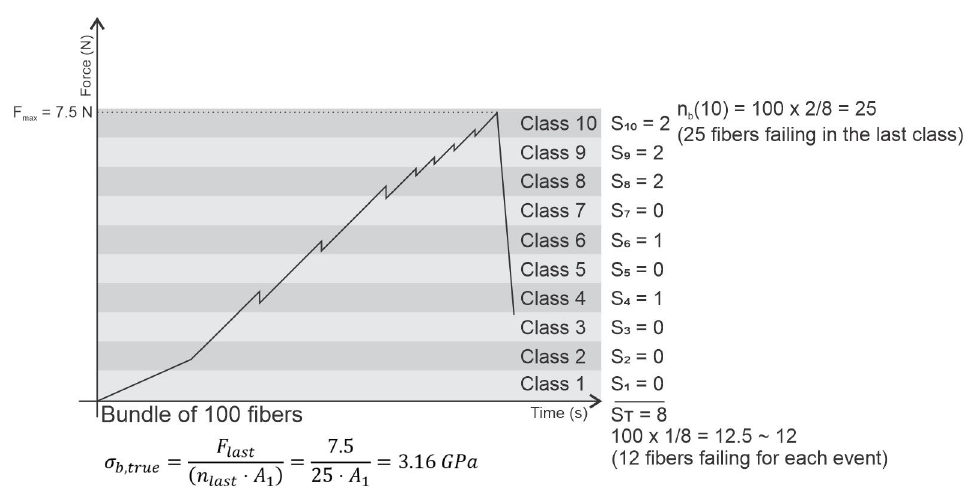
Figure 1. Schematic representation of the procedure to determine the true strength of a fiber bundle sample.